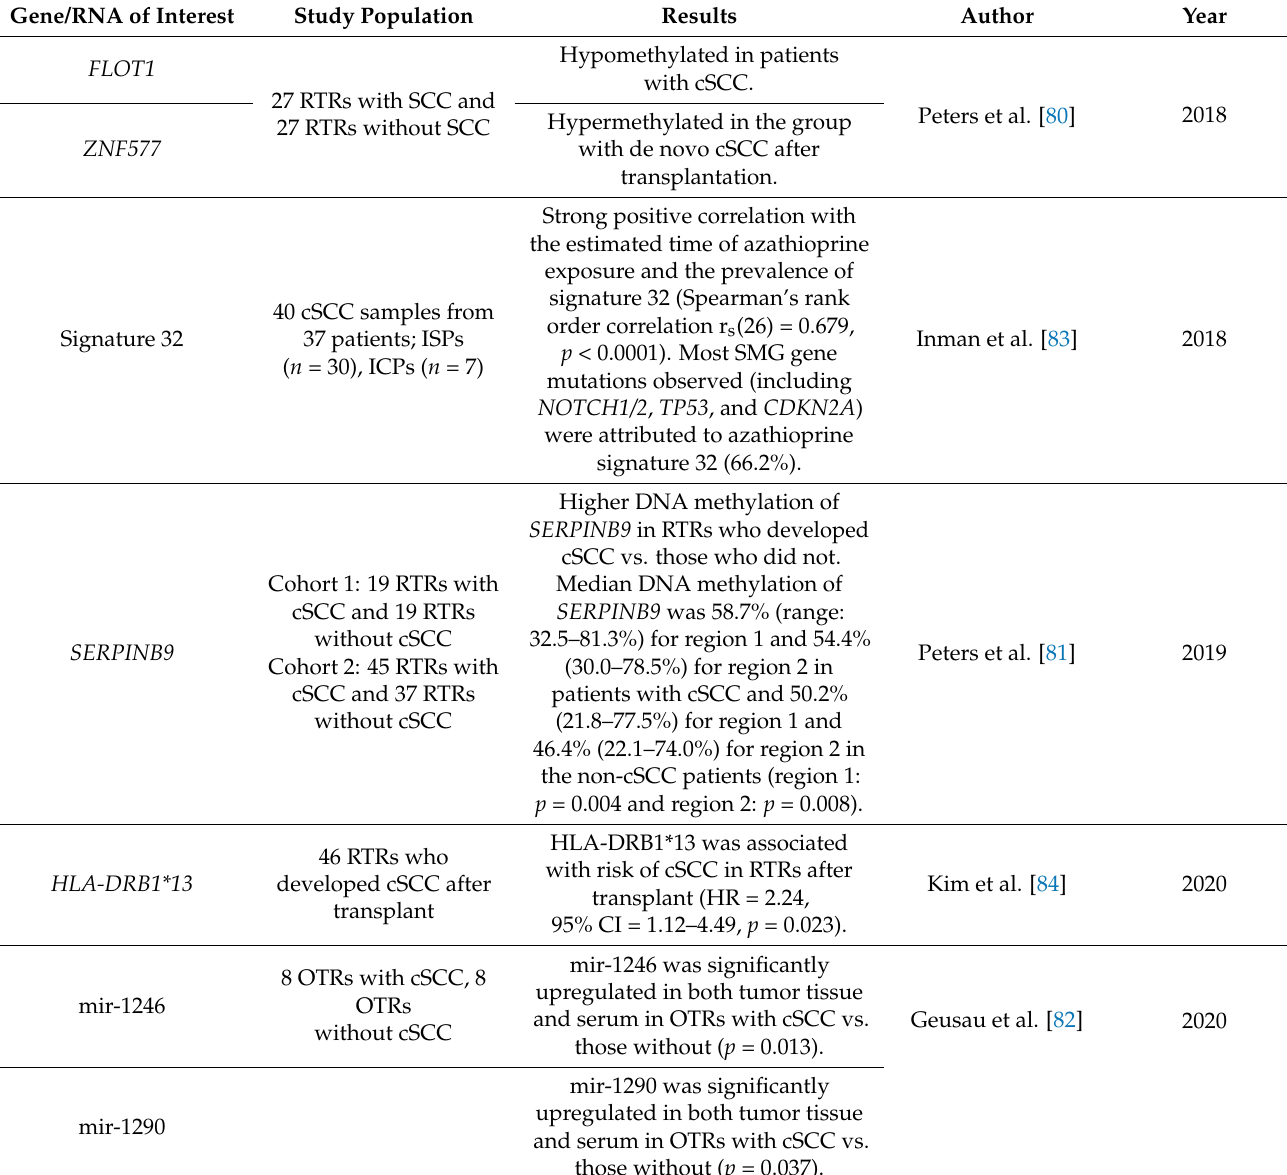
Table 9. Genetic and epigenetic alterations associated with cSCC in the